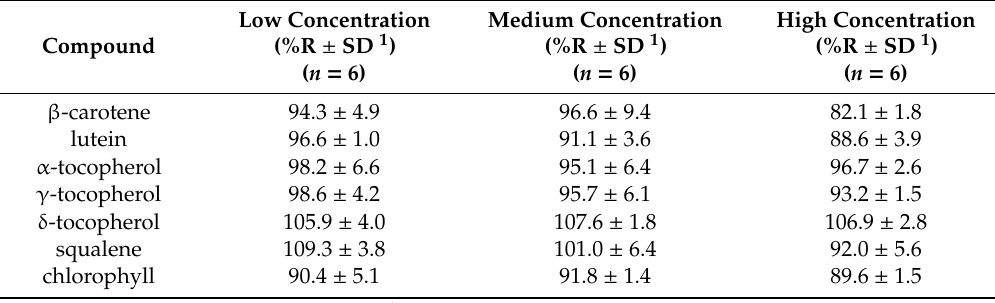
Table 3. %Recoveries (%R) for evaluation of repeatability.